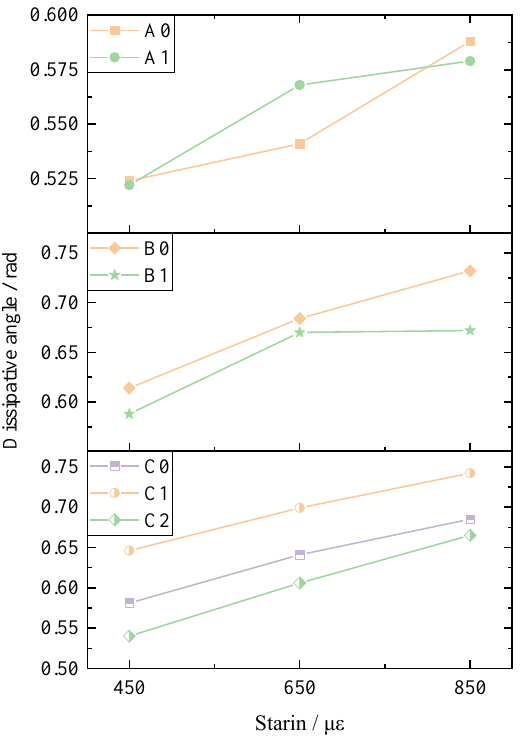
Figure 6. Dissipative angles under different